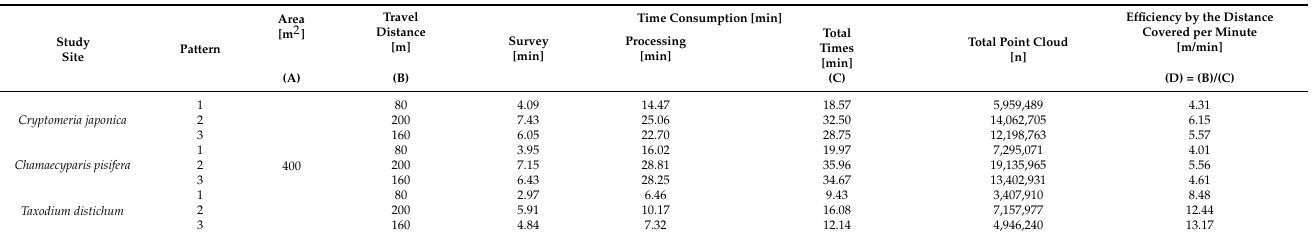
Table 11. Comparison of the amount of time required to gather and process data with the BPLS according to scan patterns.